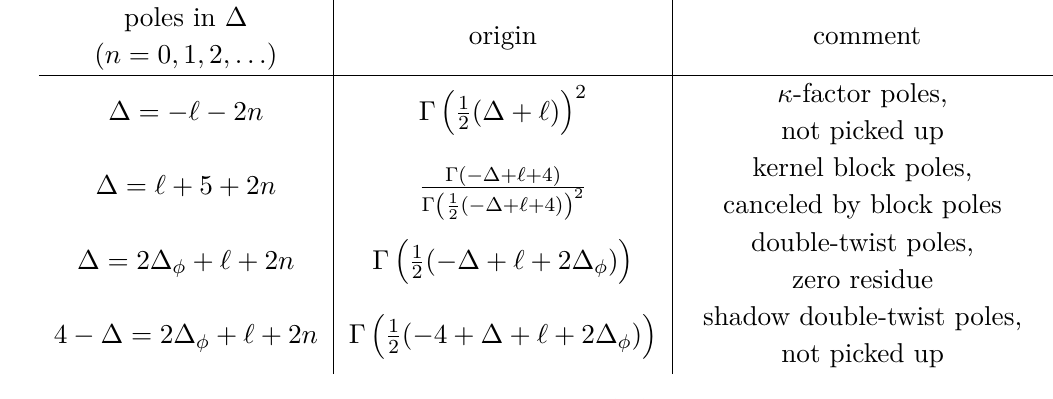
Table 3. Poles in ∆ of c ( − 2) (∆ , ‘ ; ∆ φ )